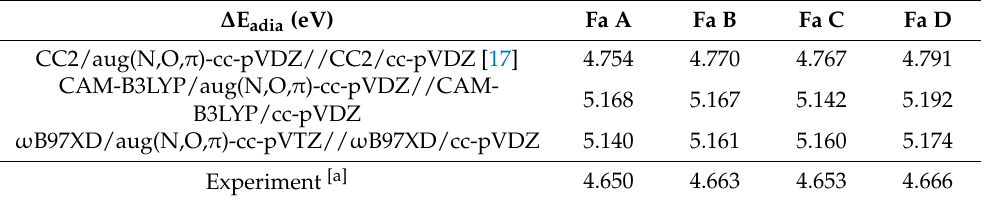
[a] The experimental values take into account the number of significant digits obtained in the experiment, and the theoretical values are given with the same number of